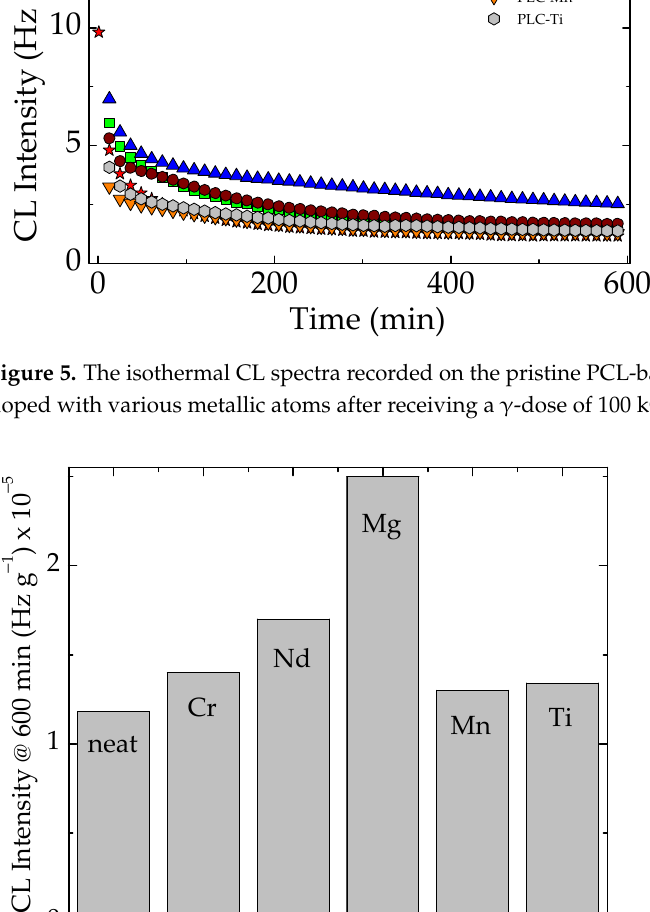
Figure 6. The CL intensities obtained at the ends of isothermal measurements on PbZrO 3 doped with various metallic atoms after the γ -irradiation of samples by an exposure of 100 kGy. Testing temperature: 140 °C.